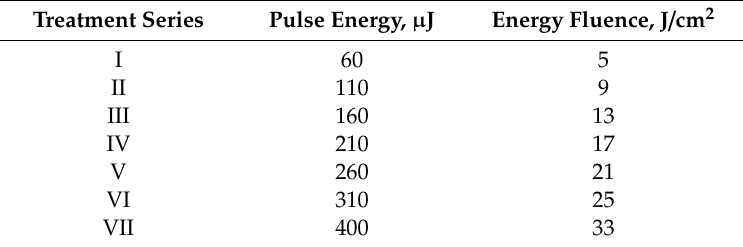
Table 2. Laser beam spot parameters for di ff erent treatment